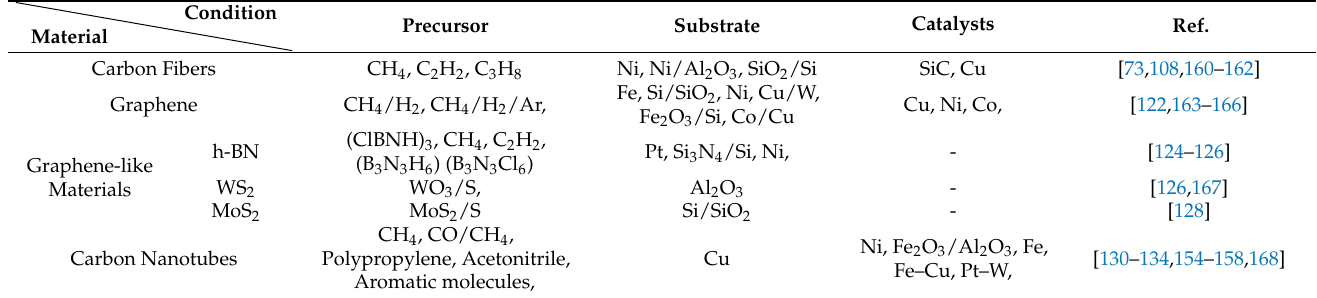
Table 2. Main conditions for preparation of carbon materials and graphene-like materials by CVD.